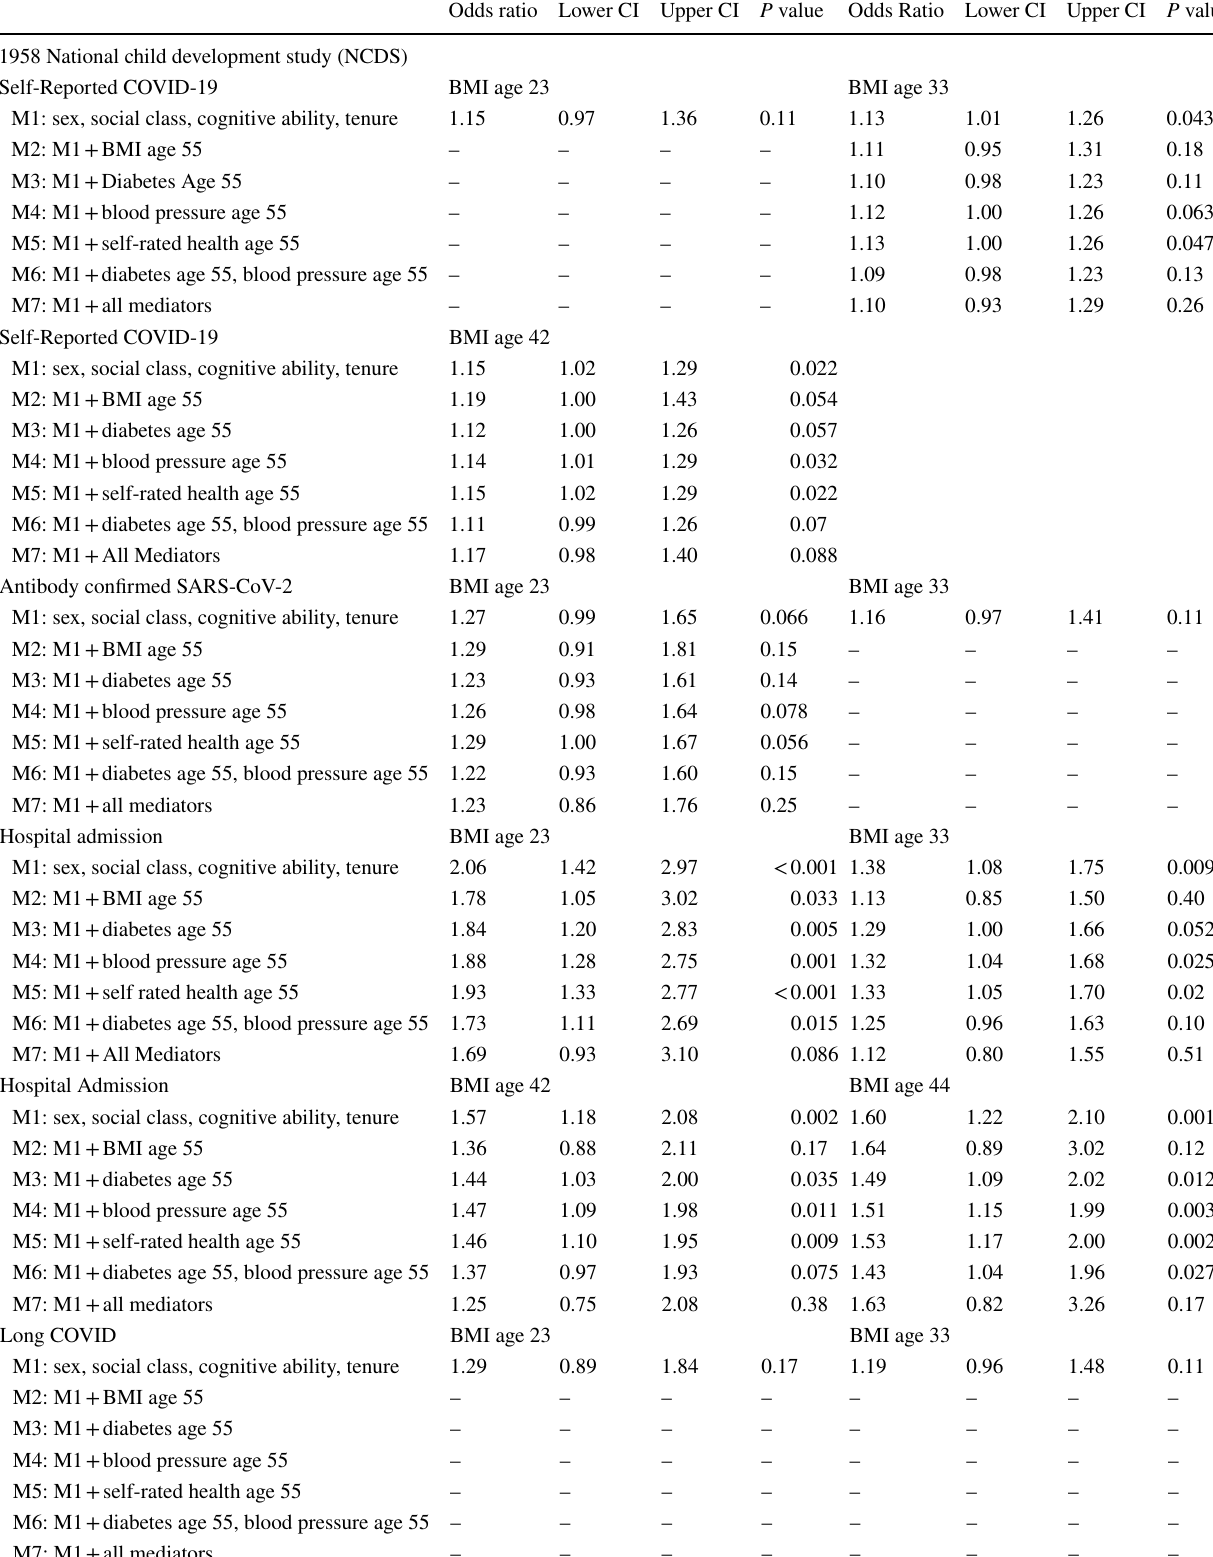
Table 2 Change in odds of COVID-19 outcomes per 5 kg/m 2 in BMI in NCDS and BCS70 adjusting for potential